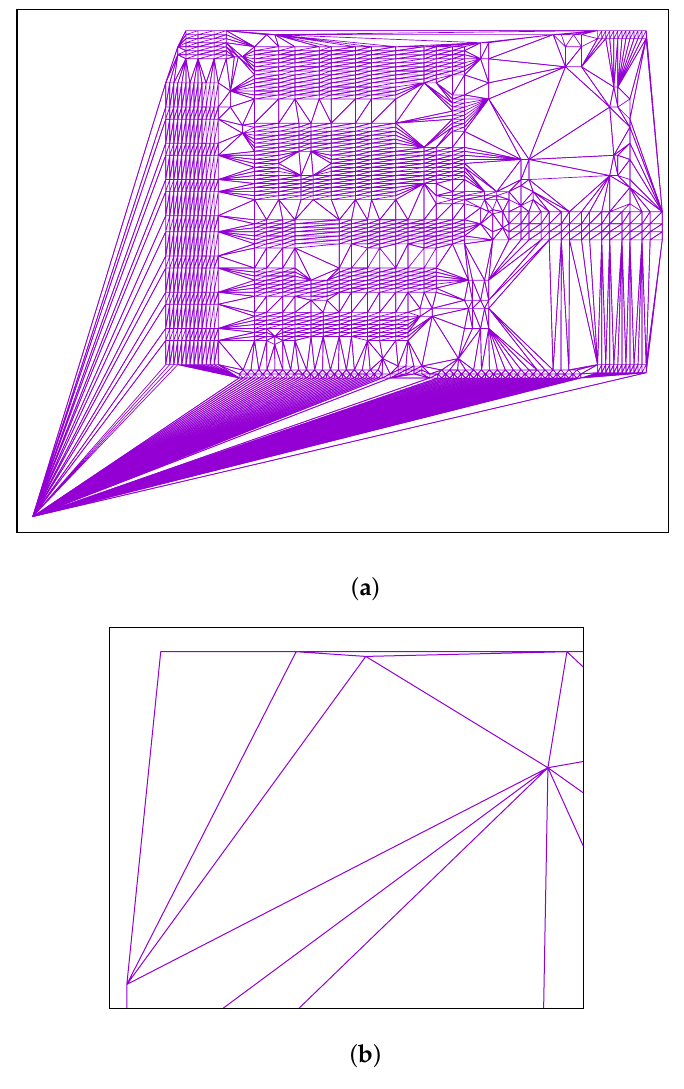
Figure 1. Triangulation of point clouds: ( a ) d1291 showing a high number of candidates for the bottom left point; ( b ) close-up of pr2392 showing the top left point with only two edges, i.e., two